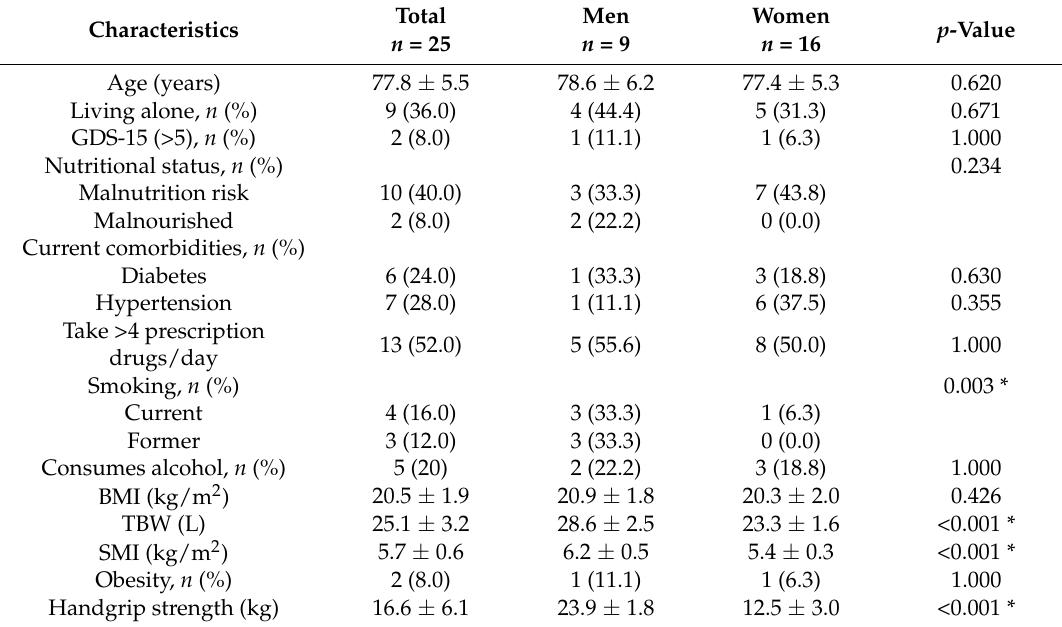
Table A2. Characteristics of the sarcopenia participants according to